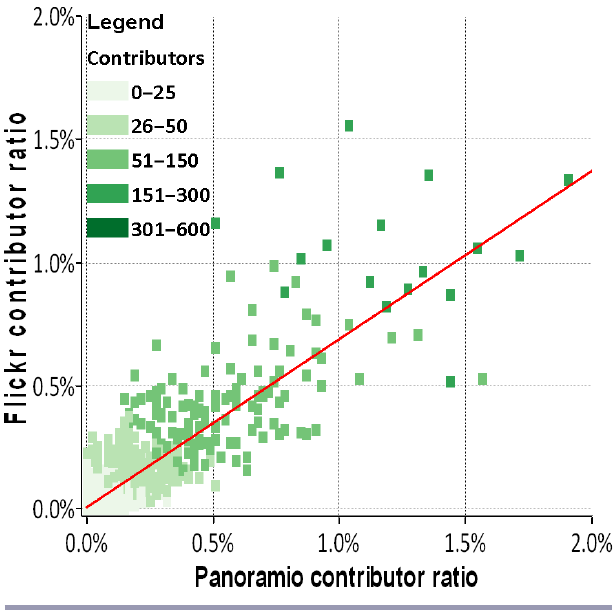
Fig. 4. Comparison of the numbers of contributors to Panoramio and Flickr for nonurban grid units.